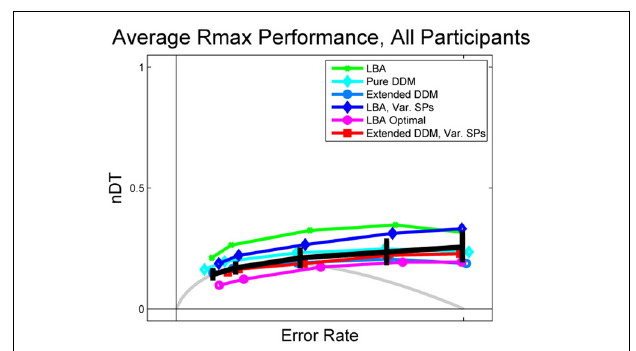
shown in purple open circles. LBA fits, shown in green, overestimate normalized DTs for both subjects. The OPC for the LBA, however, lies significantly below the data for Subject 32, because this data requires a small starting point range A to get low DTs in difficult tasks, and a low A yields low DTs throughout.